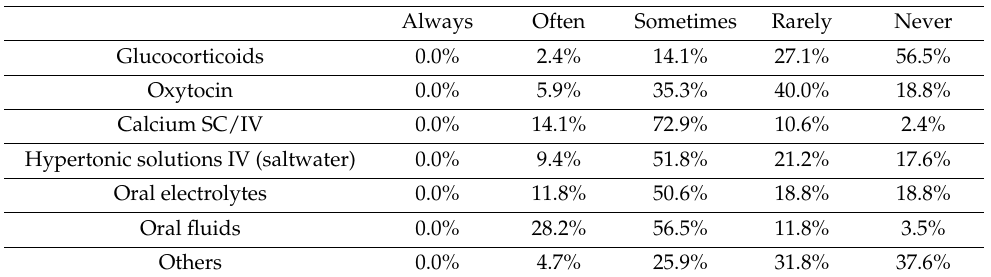
Table A4. Answers from 85 Danish veterinarians to closed questions about the use of supportive treatment, other than NSAIDs, in cases of clinical